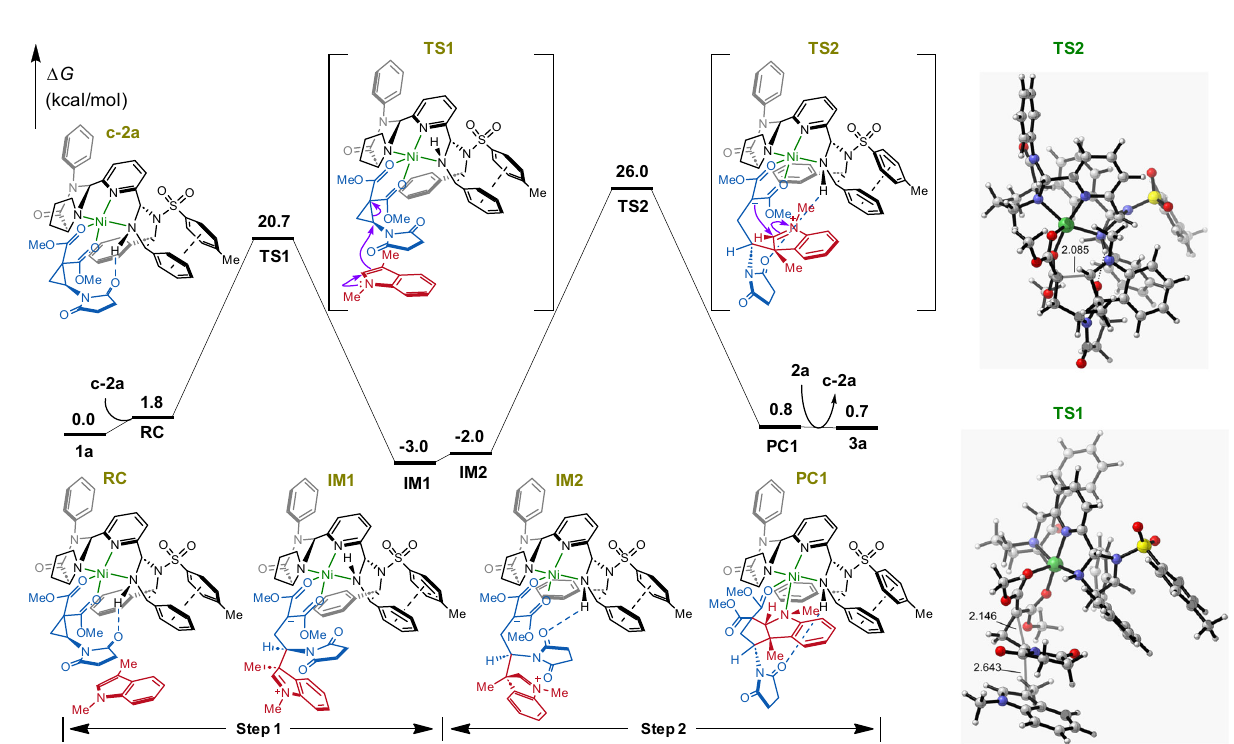
Fig. 7 | Catalytic reaction pathway. Relative energy pro fi les (in kcal/mol) of catalyzed reaction pathway and optimized structures of important transition state (bond lengths, Å) at the M06-2X-D3/Def2-TZVP/SMD(DCM)//M06-2X-D3/Def2-SVP